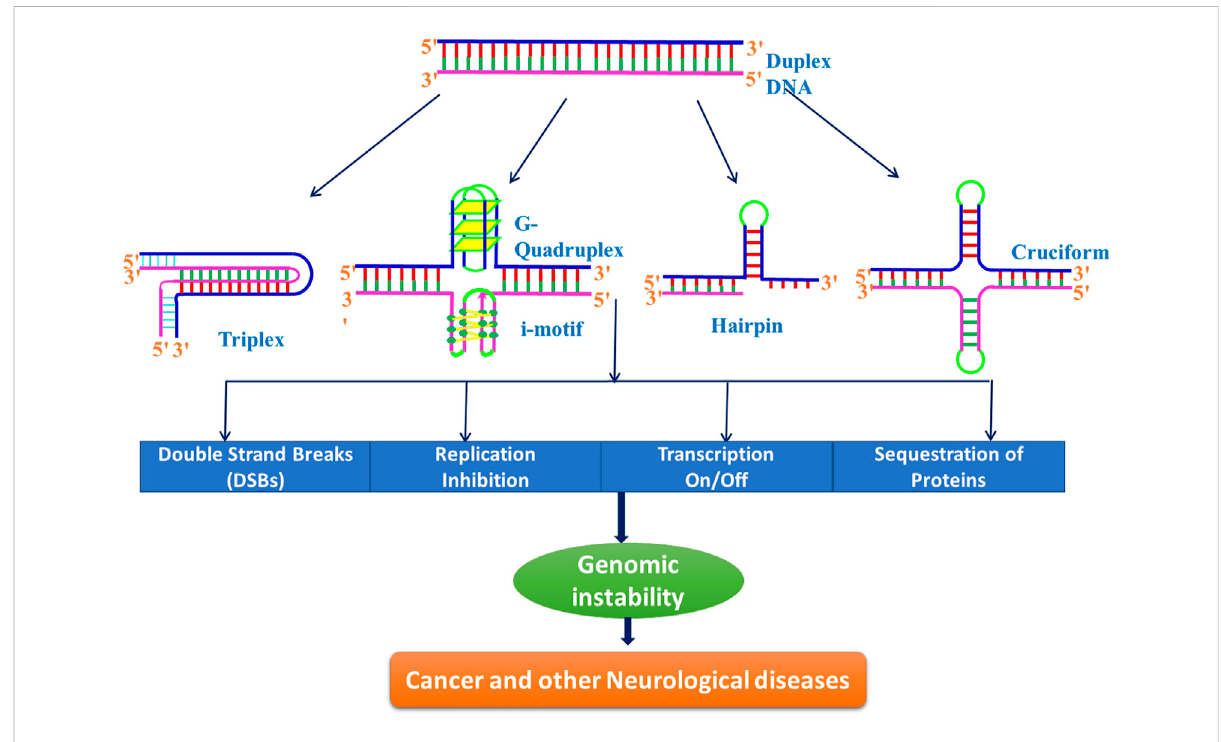
FIGURE 10 Schematic representation of role of different non-B-DNA structures in inducing genomic